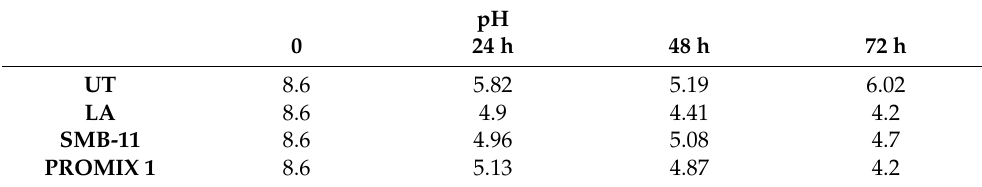
Table 3. Values of pH of fermented seaweed at 0, 24 h, 48 h and 72 h treatment. LA: Lactobacillus acidophilus; SBM-11: a mix of Lactobacillus sakei, Staphylococcus carnosus and Staphylococcus xylosus; PROMIX 1: Staphylococcus